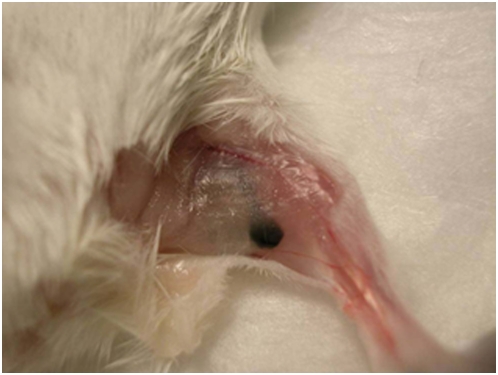
In situ photograph of lymph node metastasis from melanoma.B16-F10 melanoma cells were injected into the right footpad of C57BL/6J-TyrC-2J/J mice. Twenty days after cancer cell injection, melanoma metastases were detected in the right popliteal area.